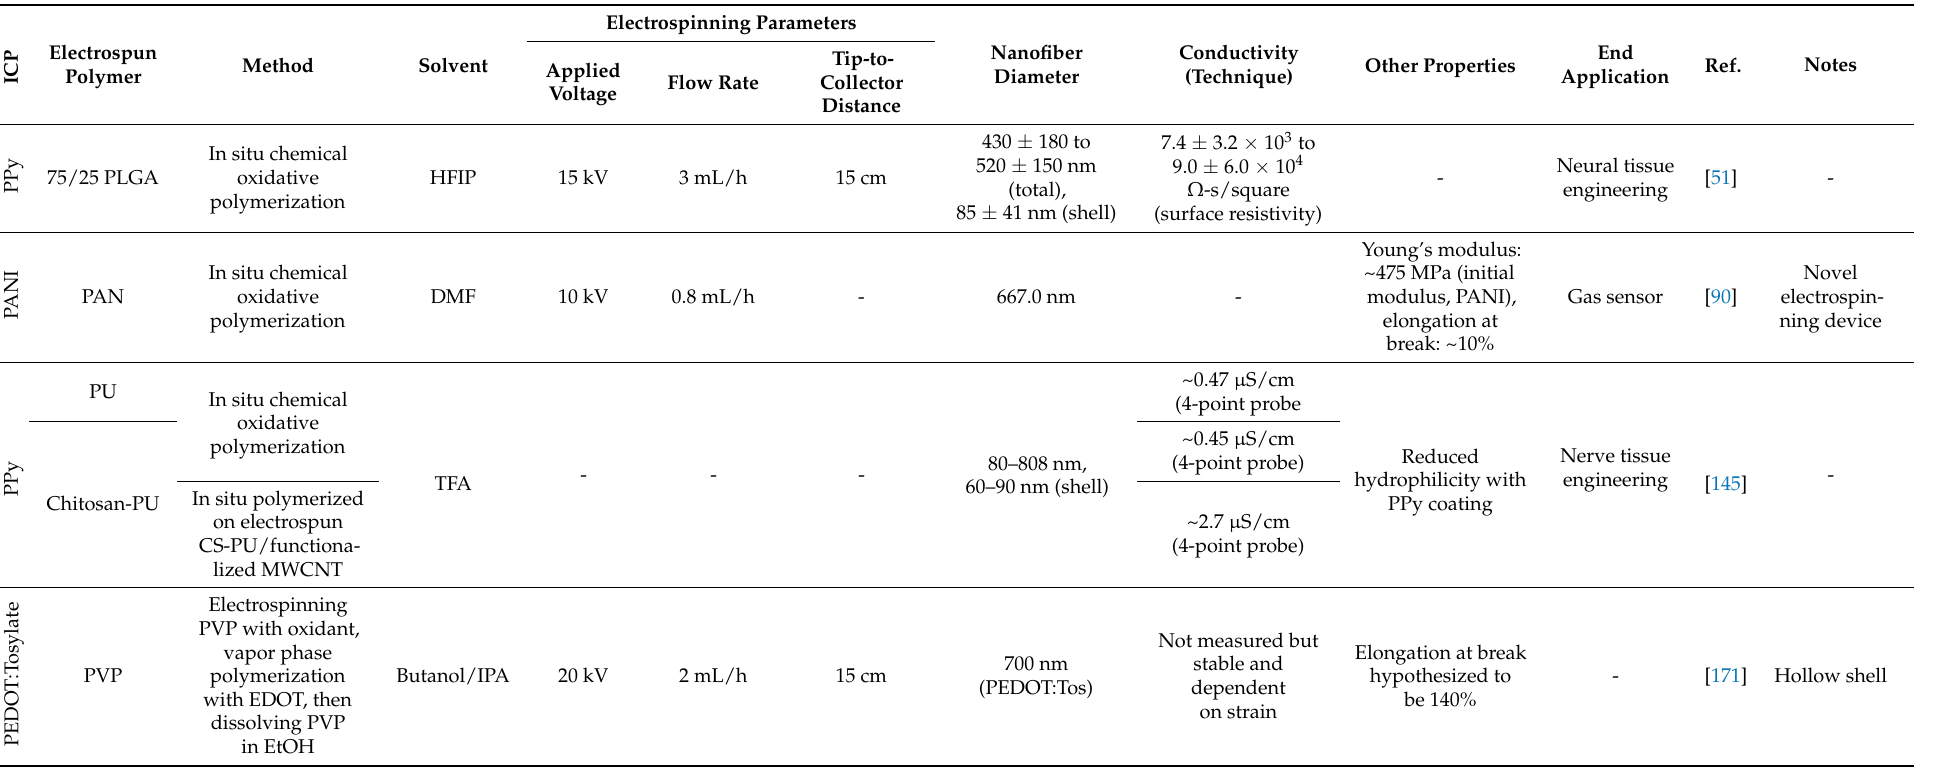
Table 4. Summary of efforts to coat electrospun polymers with